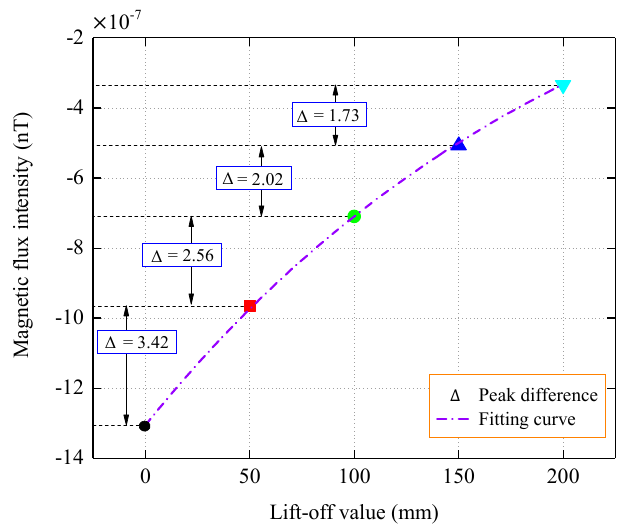
Table 3. Peak values of magnetic flux intensity under different lift-offs.